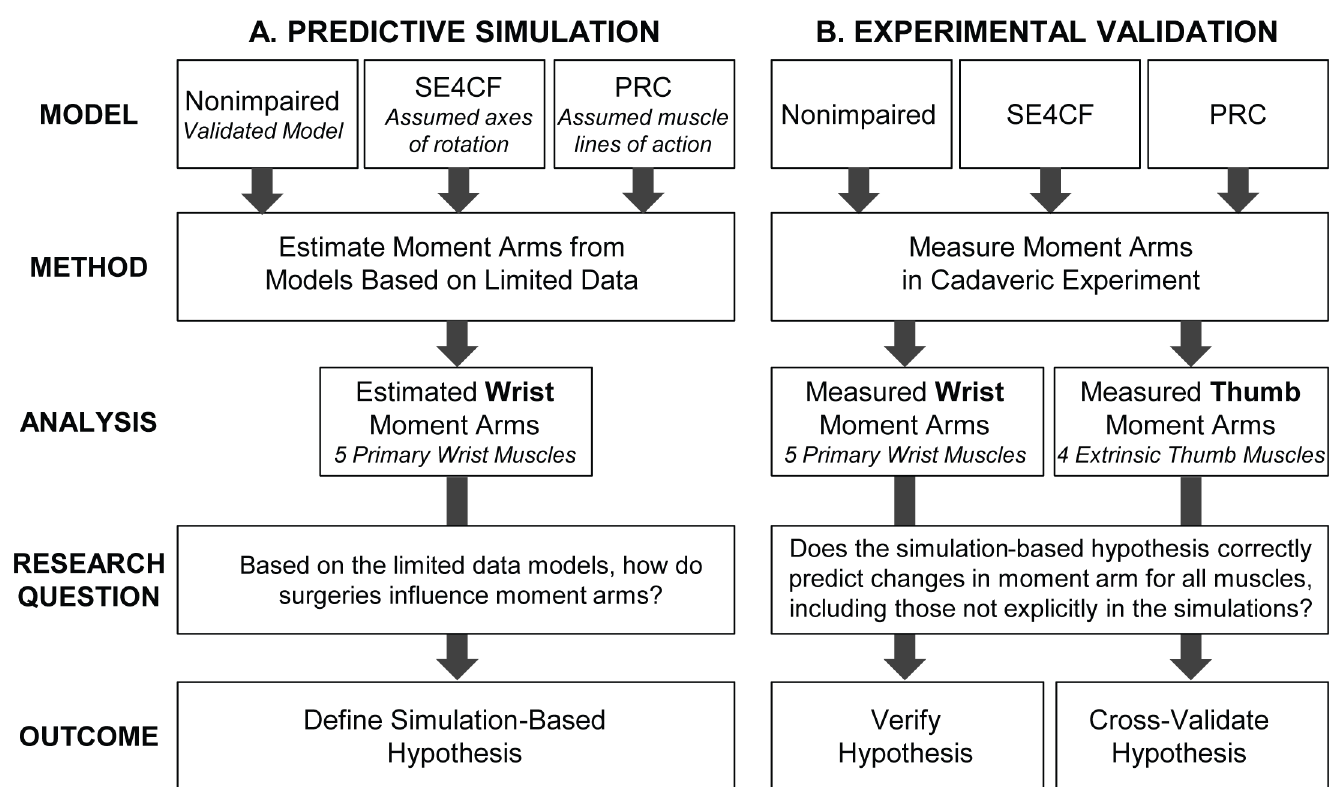
Fig 2. Study Design. Flowchart describing (A) predictive simulations to formulate a hypothesis regarding how muscle moment arms change following surgical salvage procedures and (B) the cadaveric experiment used to validate the simulation-based hypothesis.